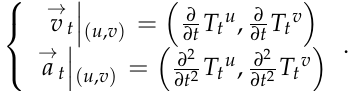
Figure 5. Illustration of edge alignment (